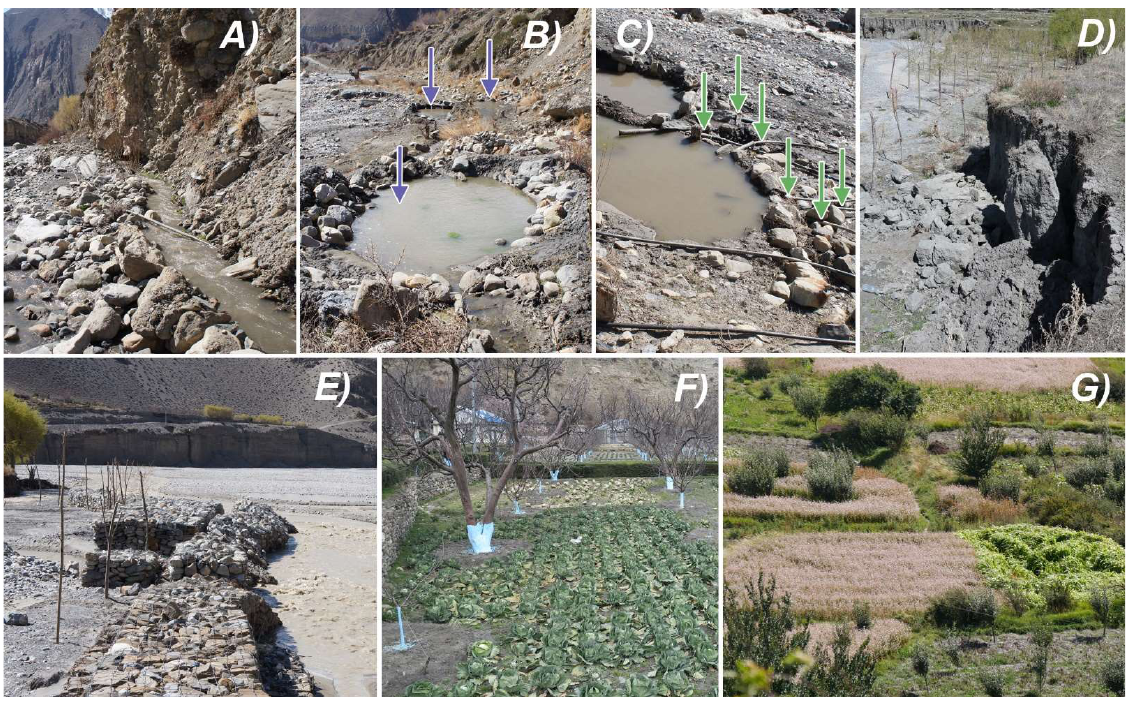
Figure 6. ( A ) Irrigation channel branching off from the Jhong Khola tributary. ( B ) Small cascading water reservoirs (blue arrows) and sediment sinks used for irrigation or ( C ) for water supply to the households (pipelines: green arrows). ( D ) Undercutting and erosion of the terrace rims at Kagbeni. ( E ) Gabions and Salix spp. were installed to prevent ongoing erosion. ( F ) Fruit and vegetable